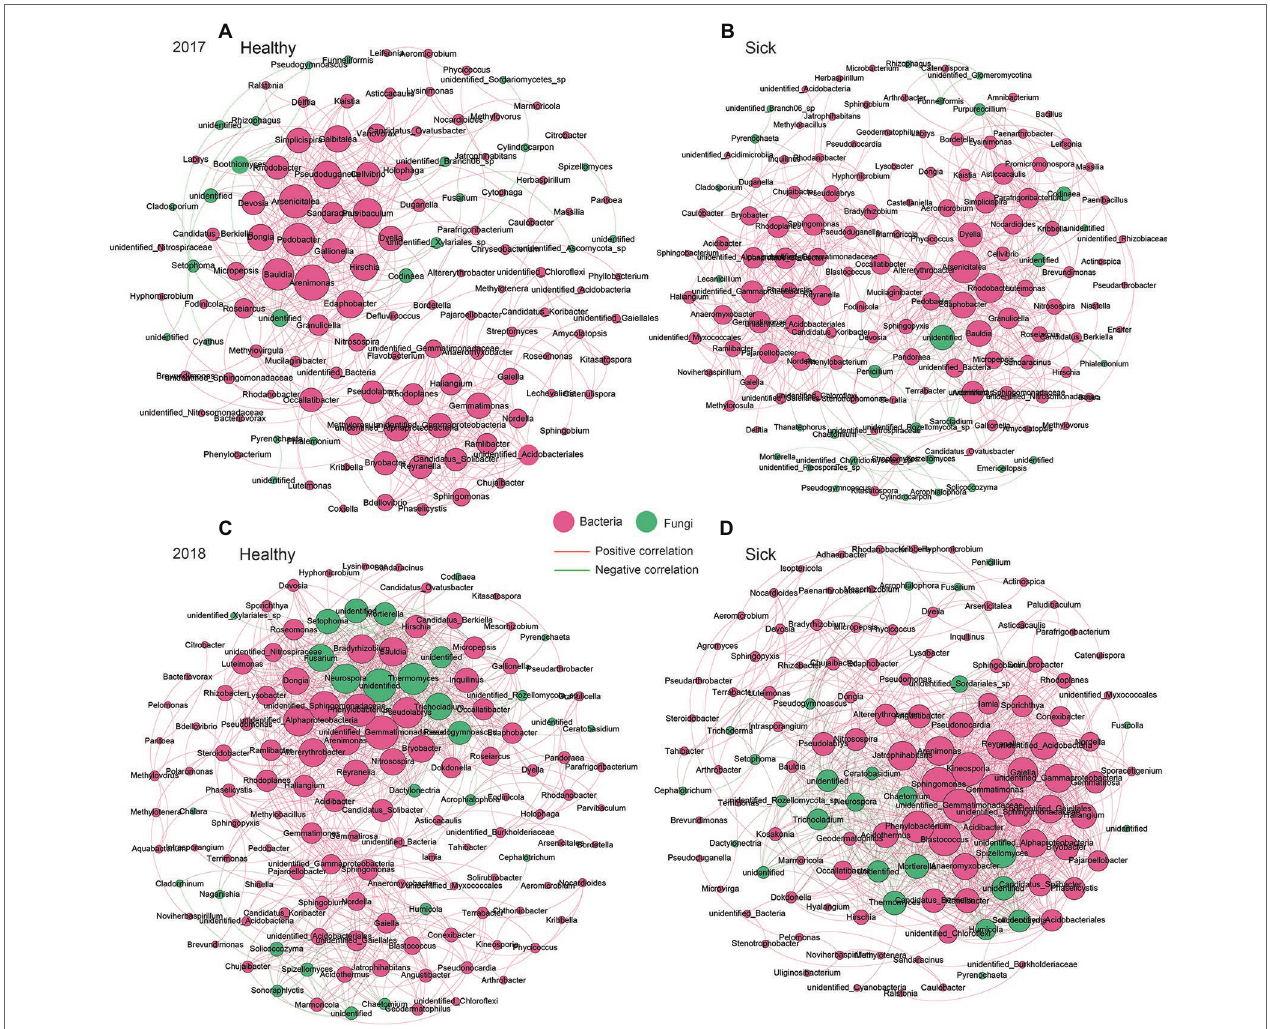
FIGURE 6 | Co-occurrence network relationship between the healthy group and the sick group. (A) Healthy tobacco in 2017. (B) Sick tobacco in 2017. (C) Healthy tobacco in 2018. (D) Sick tobacco in 2018. Screen the correlation greater than 0.8, p < 0.05. The red edges represent bacteria, and the green edges represent fungi, the red lines between the nodes indicate a positive correlation, and the green lines indicate negative